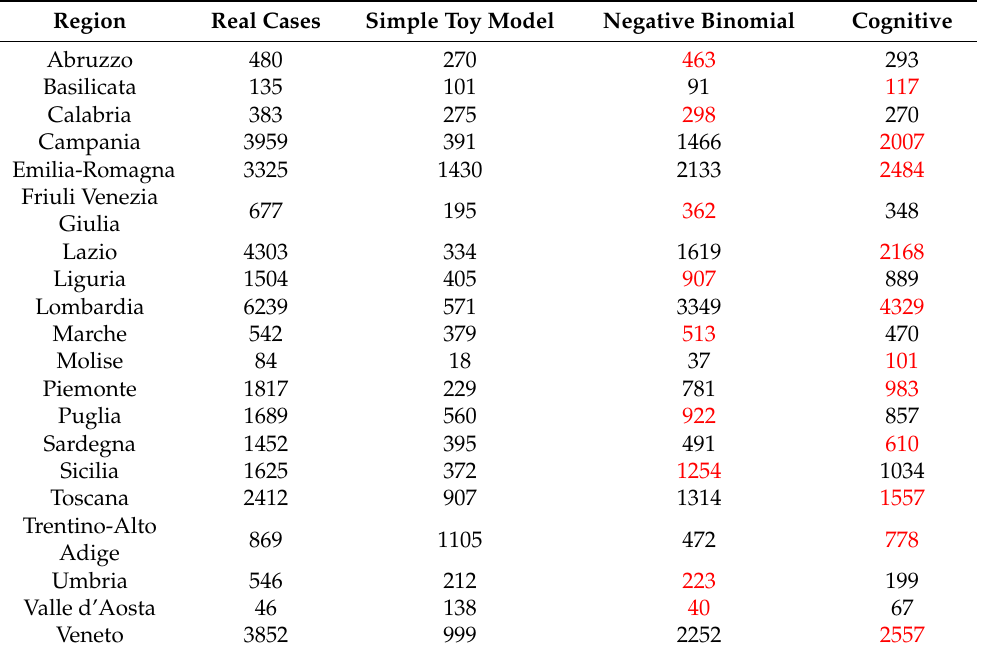
Table 4. Cumulative number of new infection cases as predicted by different models. Period: 15 August– 15 September. Values in red correspond to the model with the smallest absolute error on that prediction, with respect to the other